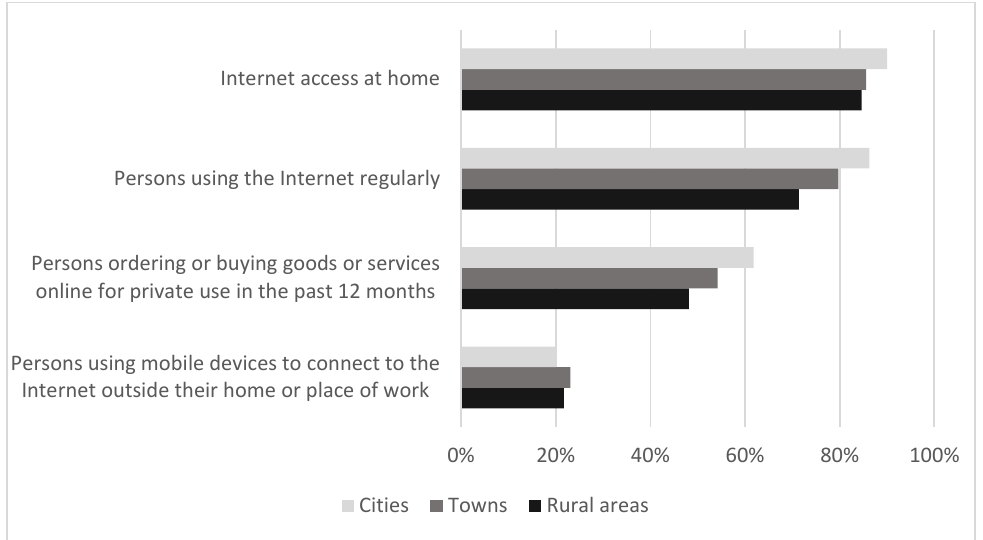
Figure 8. The use of the internet in 2019 by place of residence (source, own study based on information society in Poland, 2019).